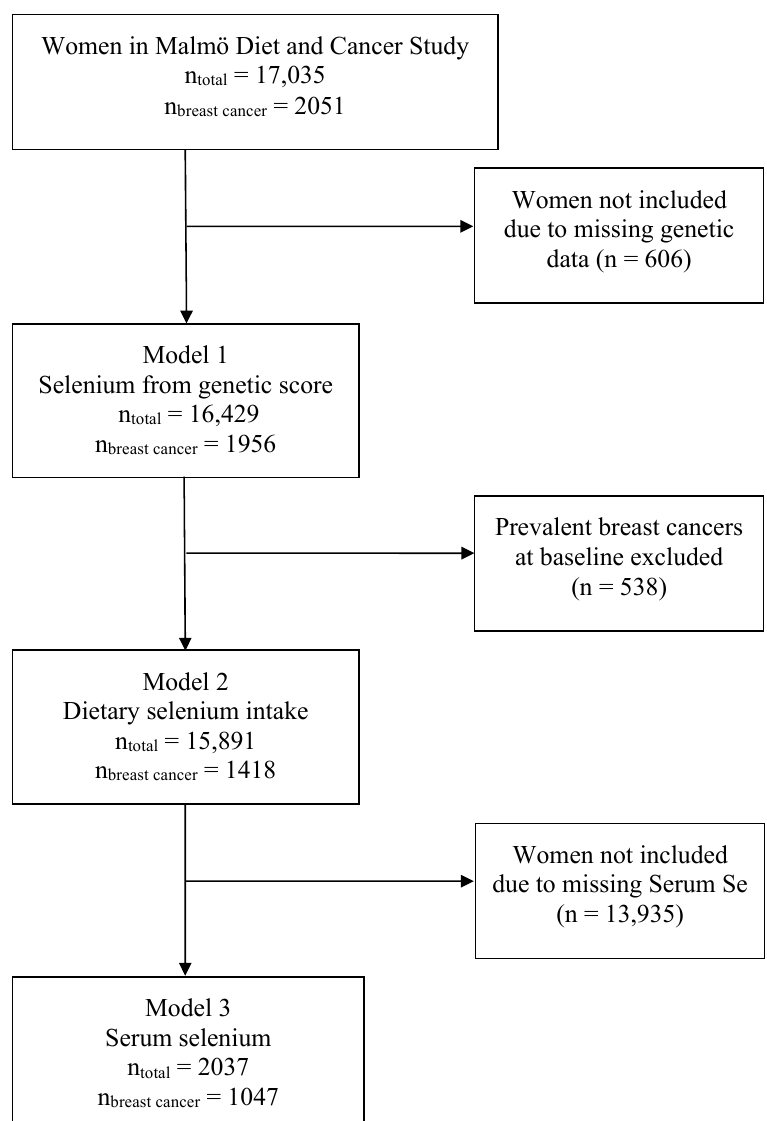
Figure 1. Inclusion and exclusion flowchart.